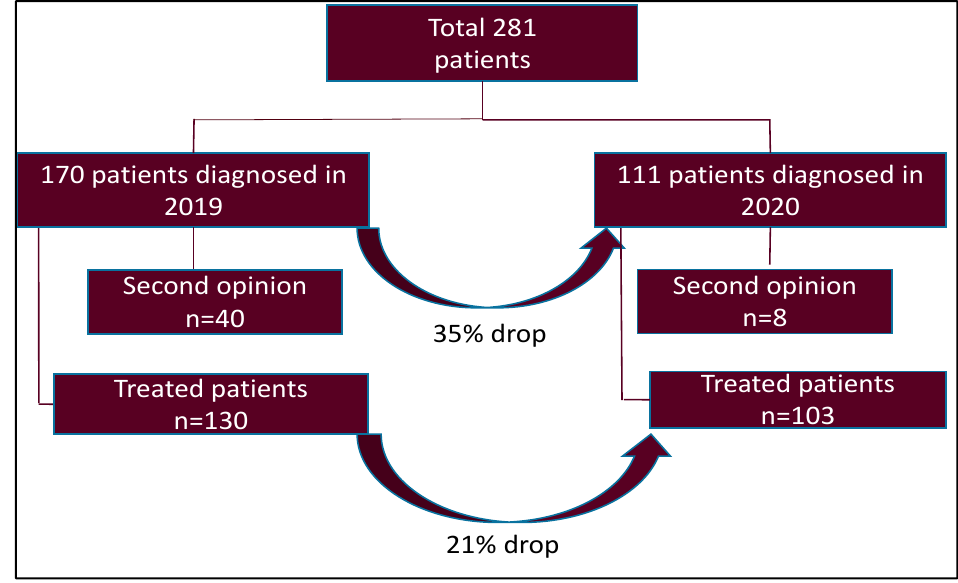
Figure 1. Patient flow chart. Patients’ characteristics are presented in Table 2. There was no difference between the two cohorts. In both cohorts the mean age of the patients was similar, the majority were male, smokers, and were diagnosed with an advanced stage of lung cancer. Table 2. Patients’ characteristics.